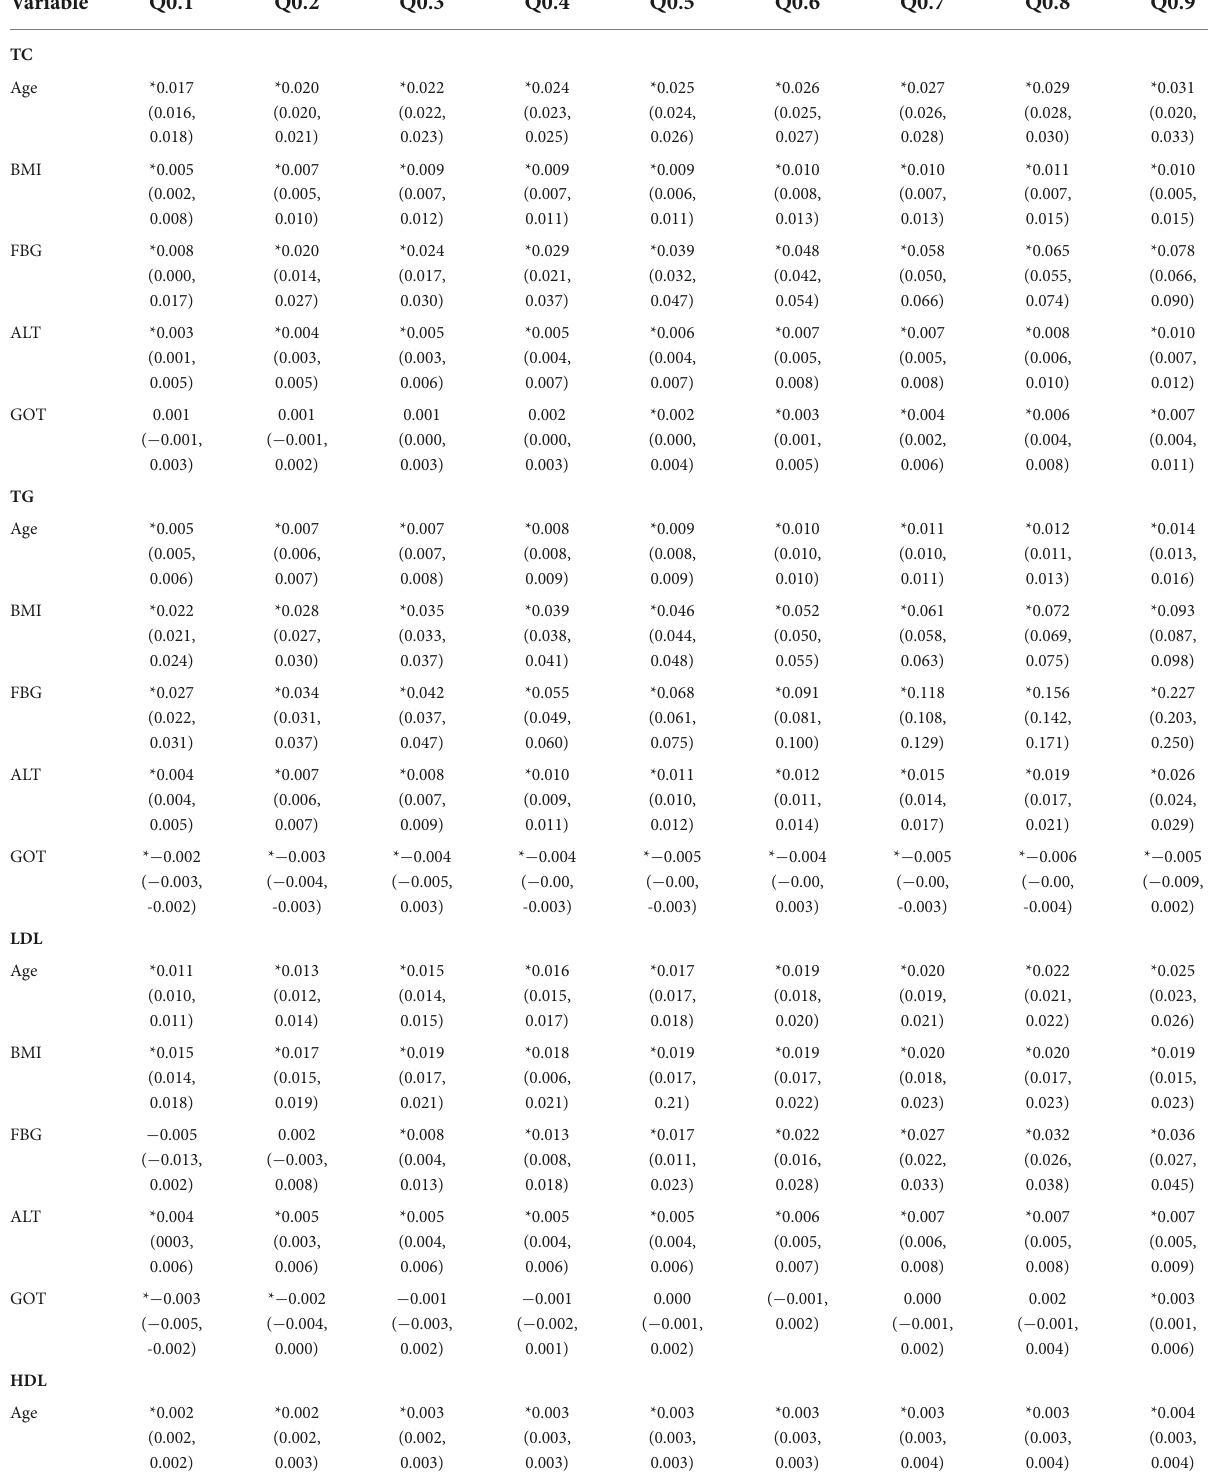
TABLE 3 Quantile regression coefficients and 95% confidence intervals between lipid levels and variables for females.